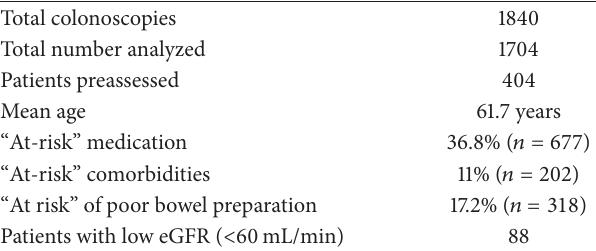
Table 1: Patient demographic characteristics.